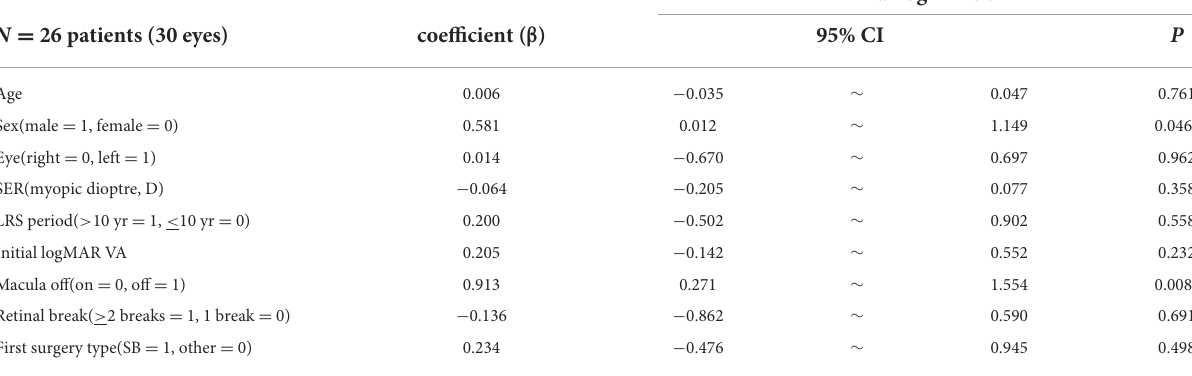
TABLE 2 Linear mixed model analysis for factors associated with final logMAR visual acuity in the RRD patients with a history of LRS for